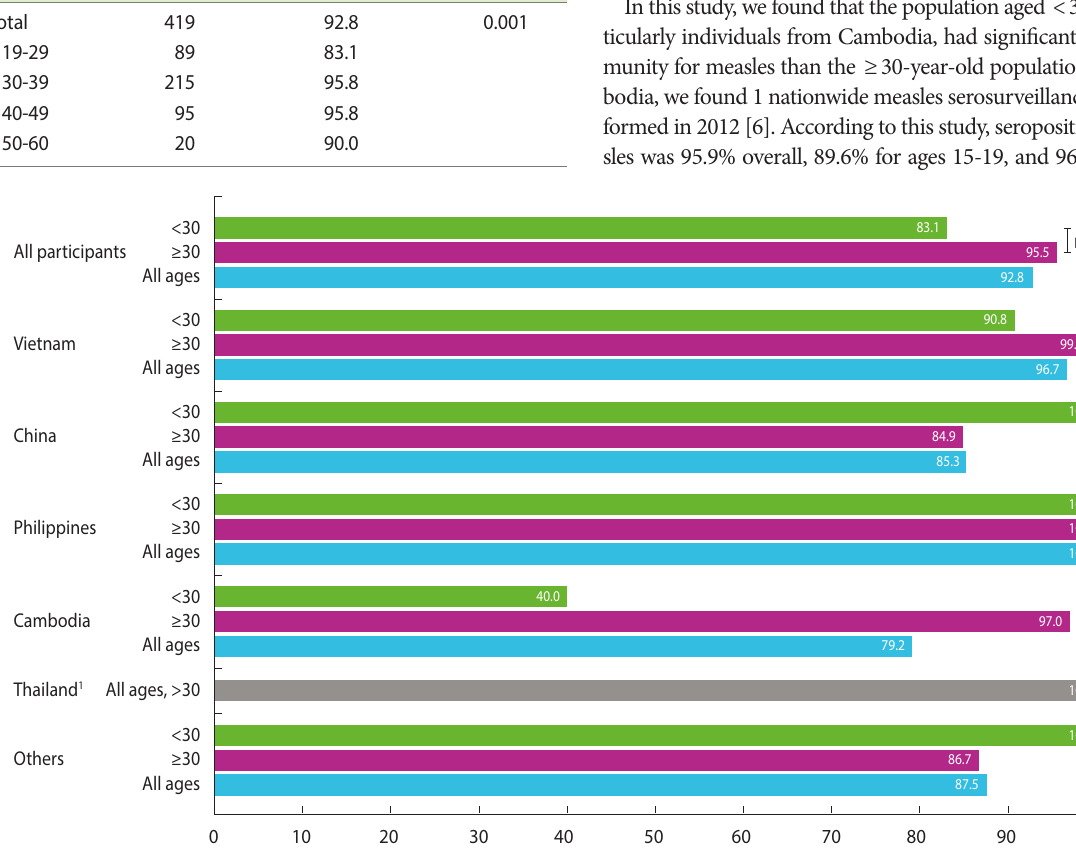
Figure 1. Prevalence of measles immunoglobulin G seropositivity by country of origin and age group. 1 All participants from Thailand were >30 years